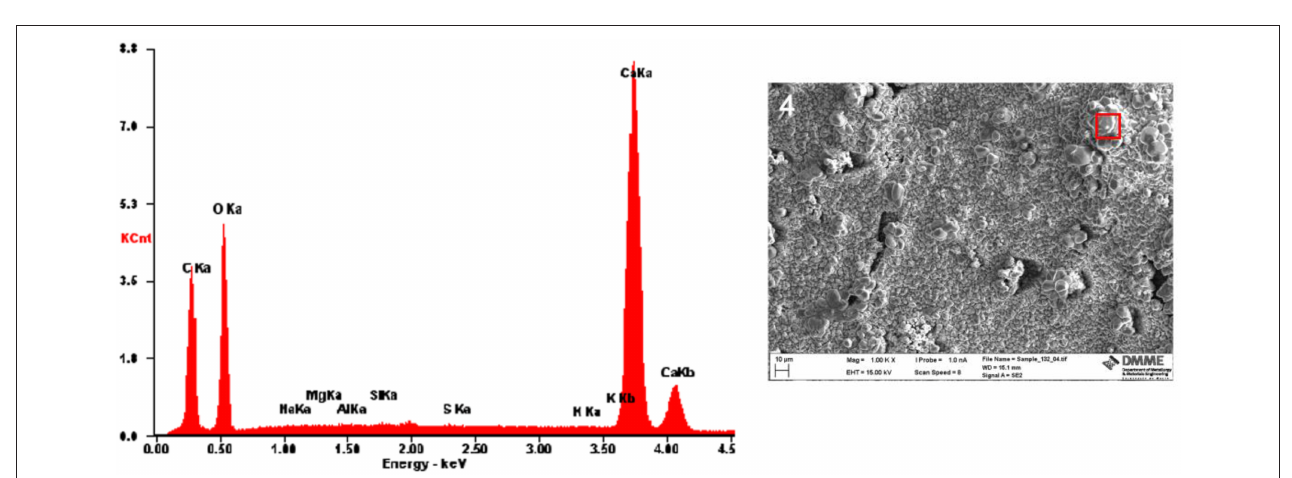
FIGURE 6 | EDS for crystals on surface of sample